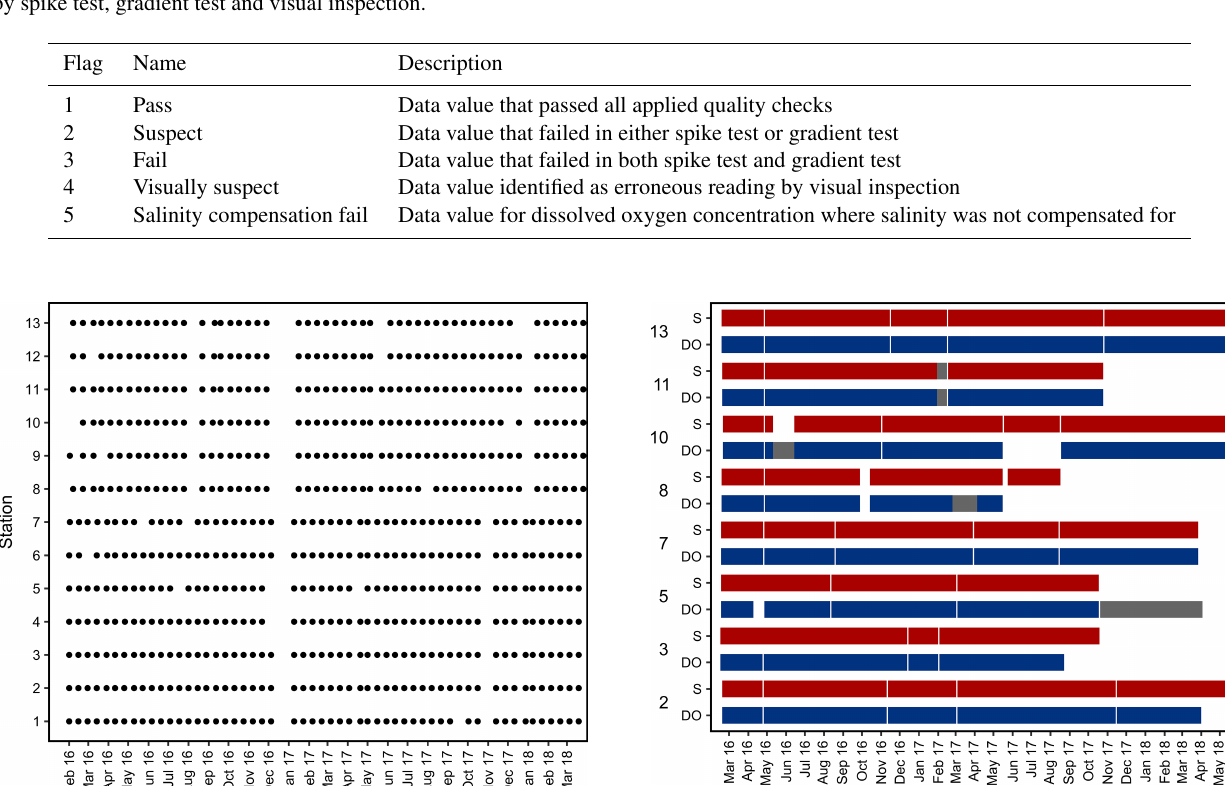
Table 4. Data quality flags assigned to records of temperature, salinity and dissolved oxygen concentration. Flags are based on quality checks by spike test, gradient test and visual inspection.